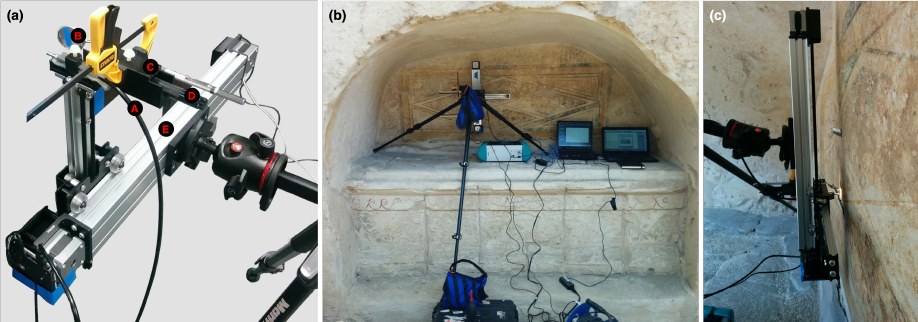
Figure 4. ( a ) The complete assembly of the scanning system: A—FO cable of the FieldSpec 3; B—mirror, clamped to mount—C; D—illumination source; E—scanner. ( b ) The SRS hyperspectral system set up to scan the painting Imitation marble in Tomb 3882. ( c ) Side profile of the scanning